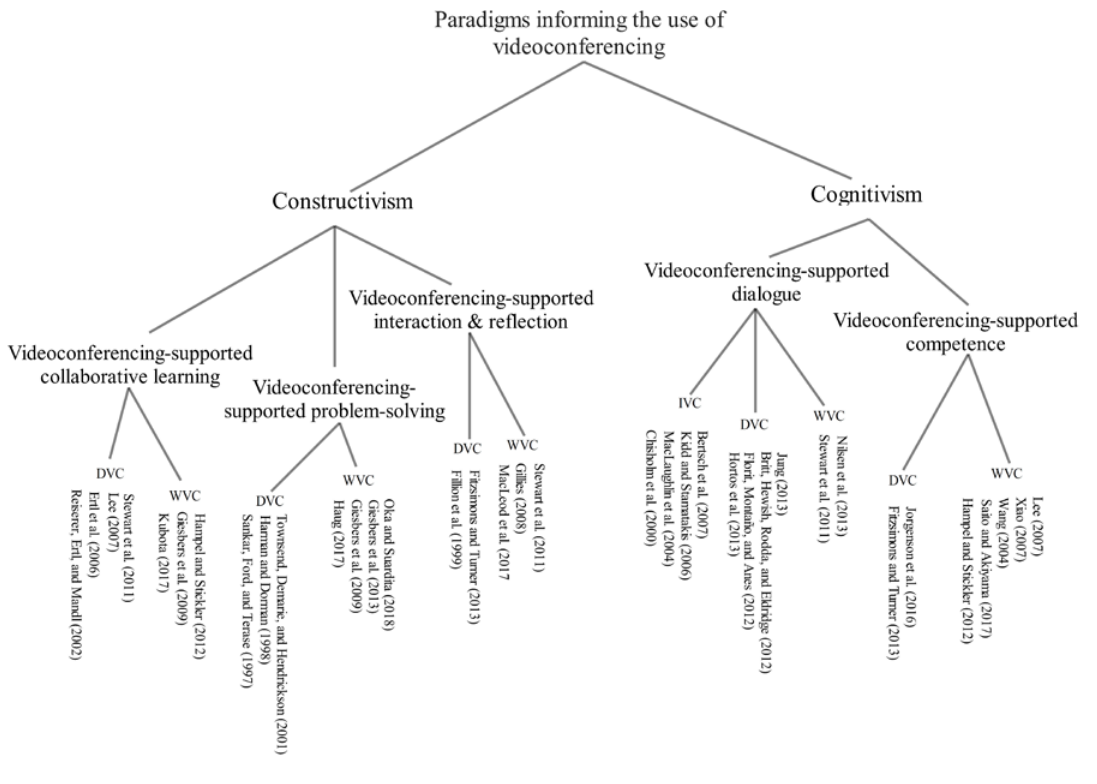
Figure 3 . Videoconferencing